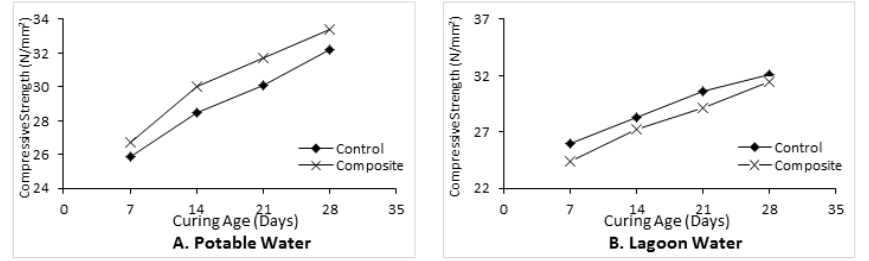
Figure 4. Variation of compressive strength of pozzolan blended steel slag aggregate concrete